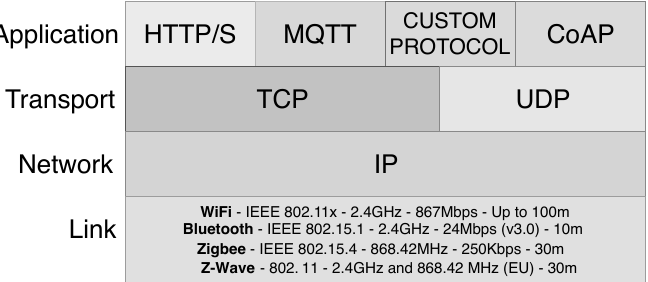
Figure 3. Protocol stack in our pilot’s device